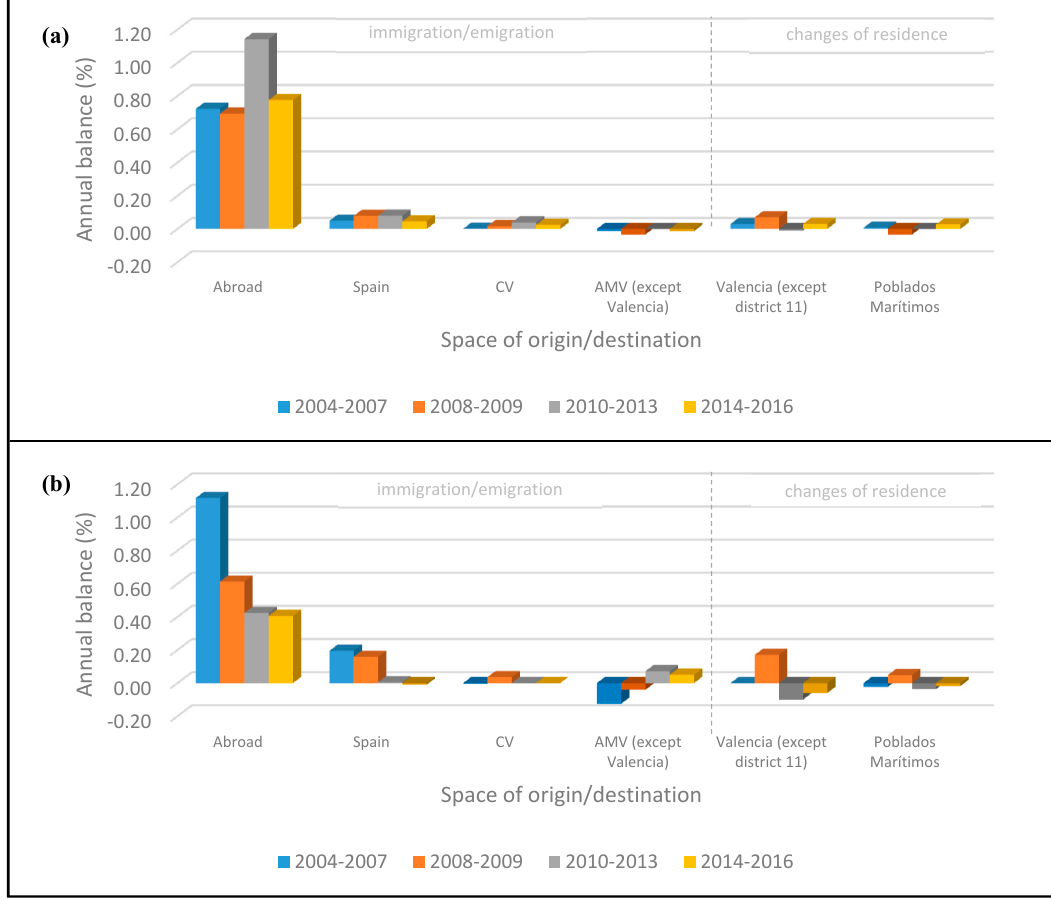
Figure 6. Total balance of EU immigrants ( a ) and non-EU immigrants ( b ) in Cabanyal, according to spaces of origin and destination, 2004–2016.